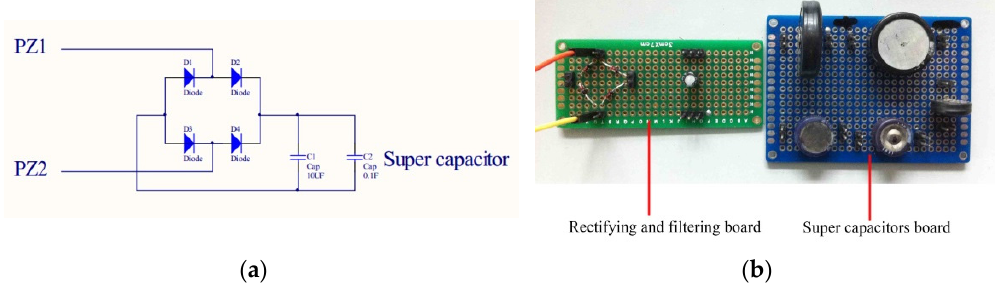
Figure 13. ( a ) Circuit schematic for rectifying and filtering AC; ( b ) Rectifying and filtering board, super capacitor board.